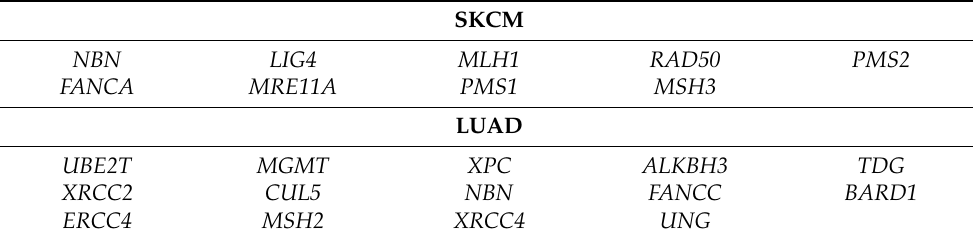
Table 1. The optimal gene sets identified for SKCM and LUAD.